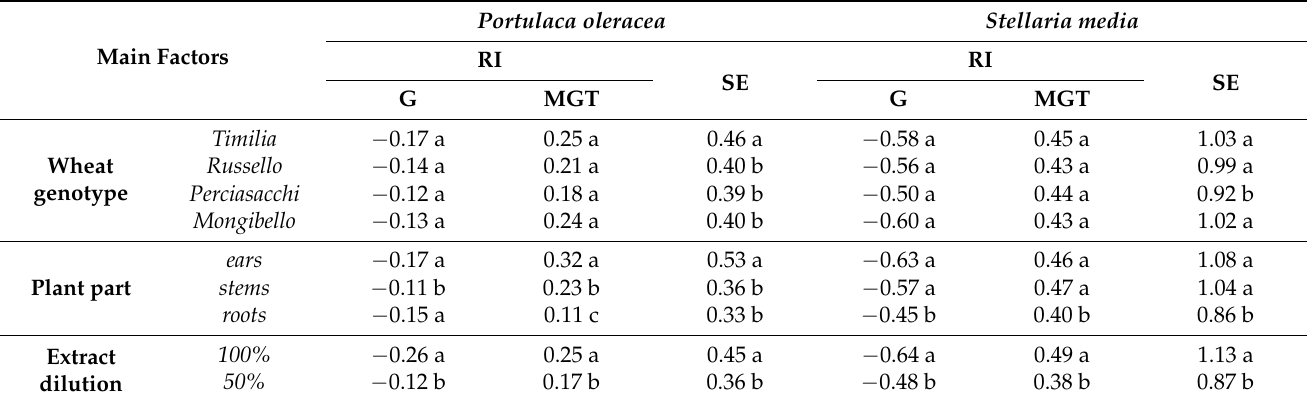
Table 2. Allelopathic effect response index (RI) and synthesis effect (SE) of durum wheat extracts on final seed germination (G) and mean germination time (MGT) of Portulaca oleracea and Stellaria media . RI and SE values are pooled over main factors.